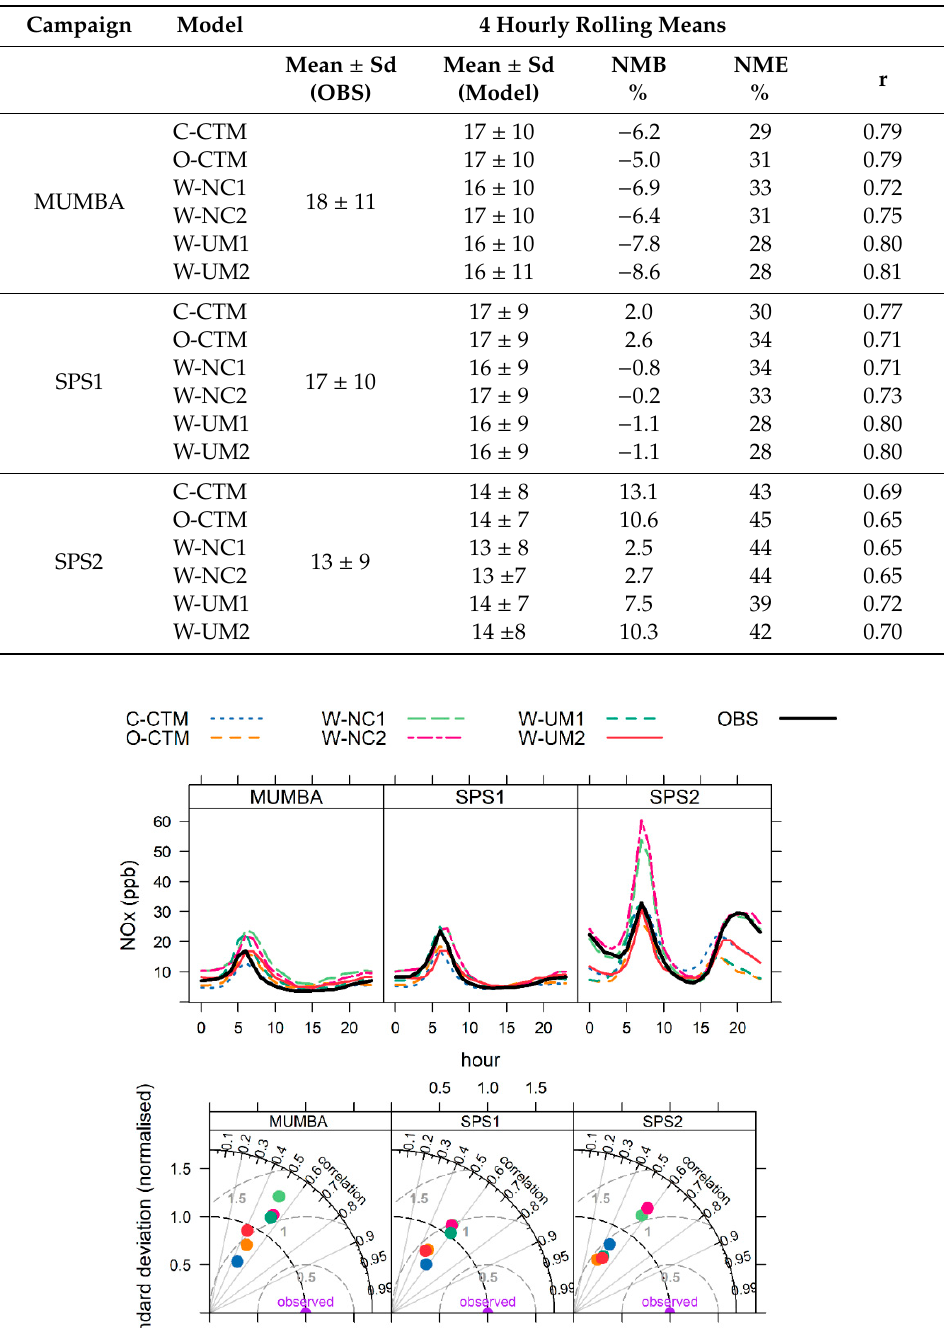
Table A2. Summary statistics for O 3 4 hourly average values are listed for each model and each campaign including mean and standard deviation (Sd); normalized mean bias (NMB); normalized mean error (NME) and correlation coe ffi cient (r).